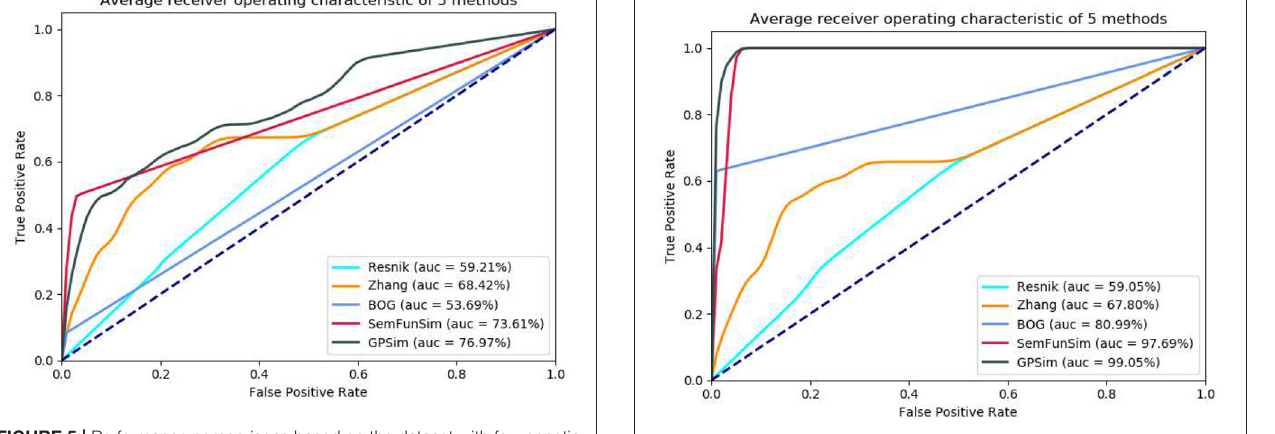
FIGURE 5 | Performance comparisons based on the dataset with few genetic information. FIGURE 6 | Performance comparisons based on all